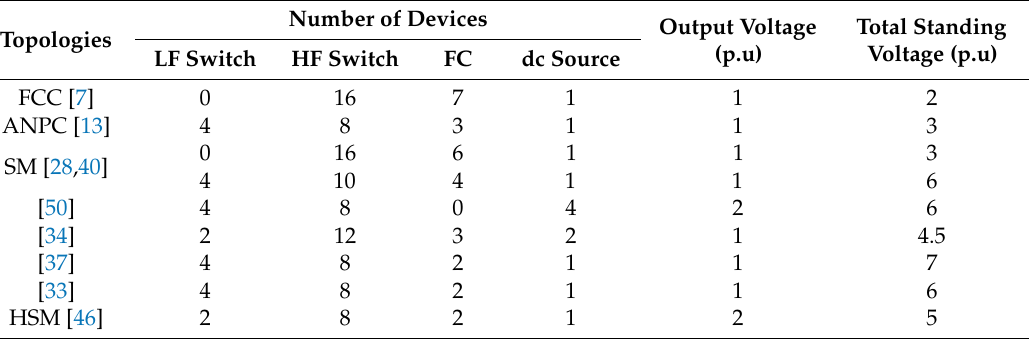
Table 1. Comparison of 9-level FC-based multilevel converters.